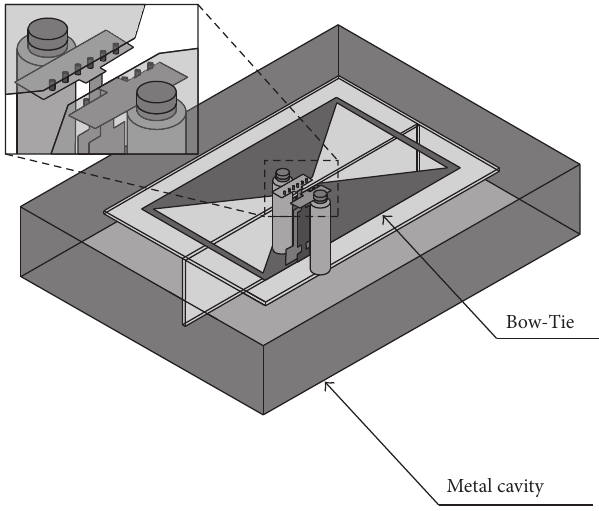
Figure 34: Geometry of the magnetoelectric dipole for unidirec- tional UWB communications [53]. The vias used to connect the antenna to the balun are indicated in the